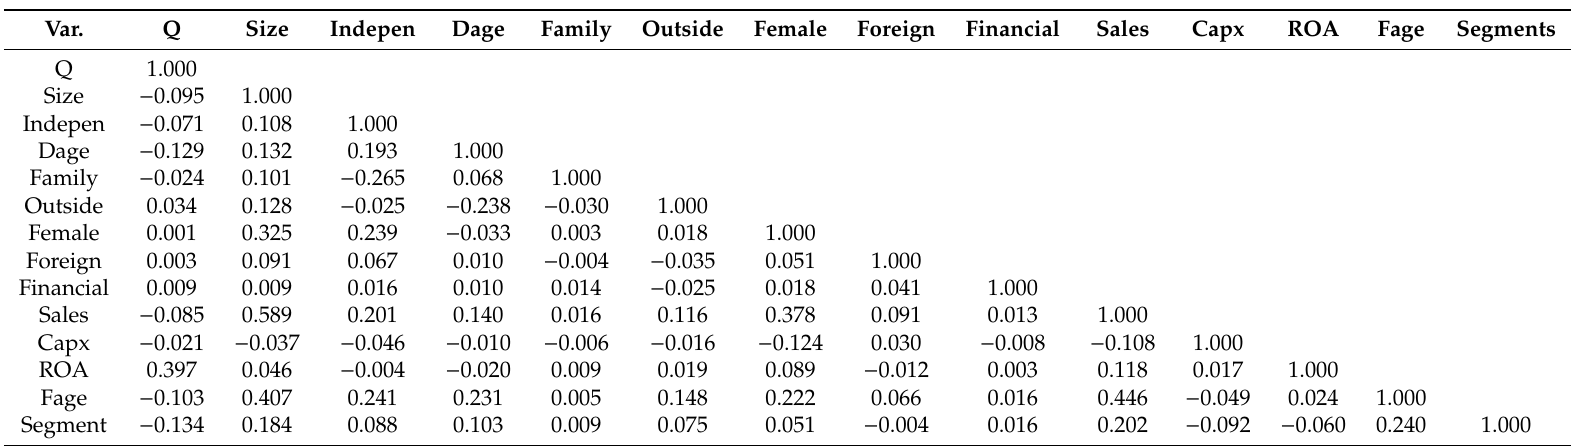
Table 2. Pearson Correlation